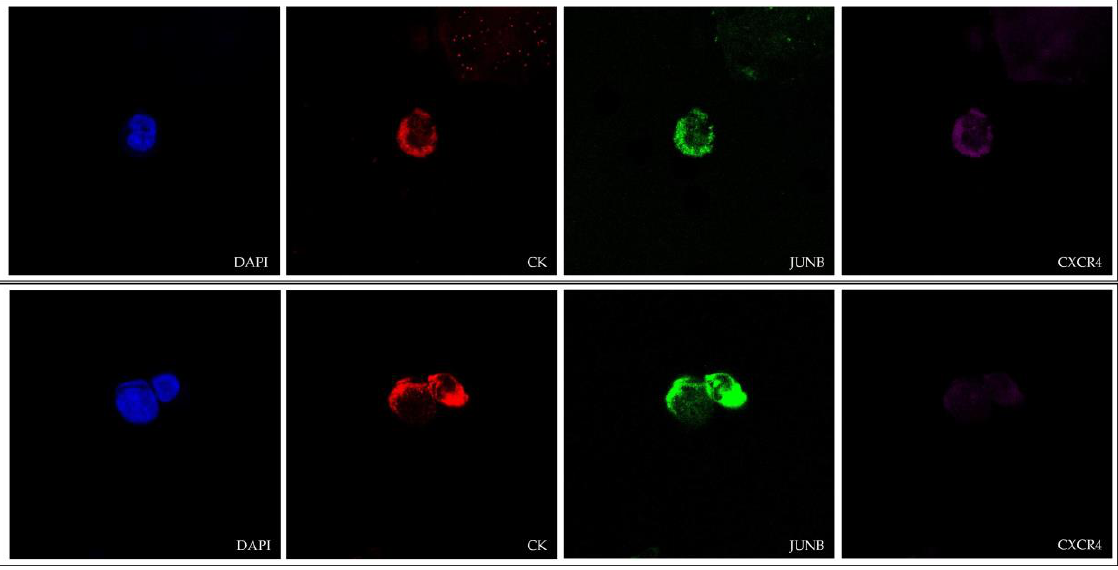
Figure 1. ( a , b ) Cytokeratin (red), JUNB (green) and CXCR4 (purple) expression in CTCs isolated from NSCLC patients (confocal microscopy). Nuclei (blue) were stained with DAPI.